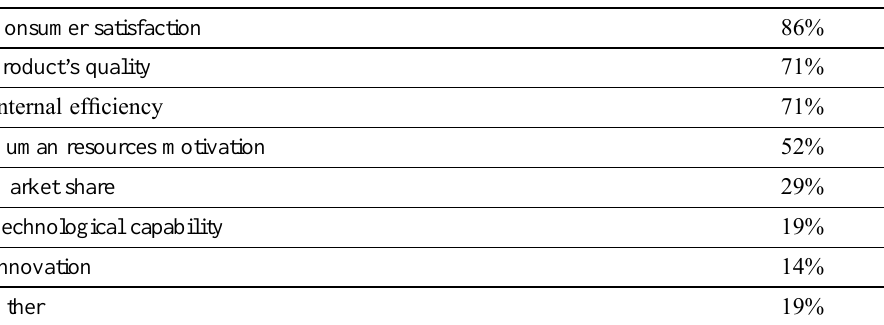
Table 14. Non financial